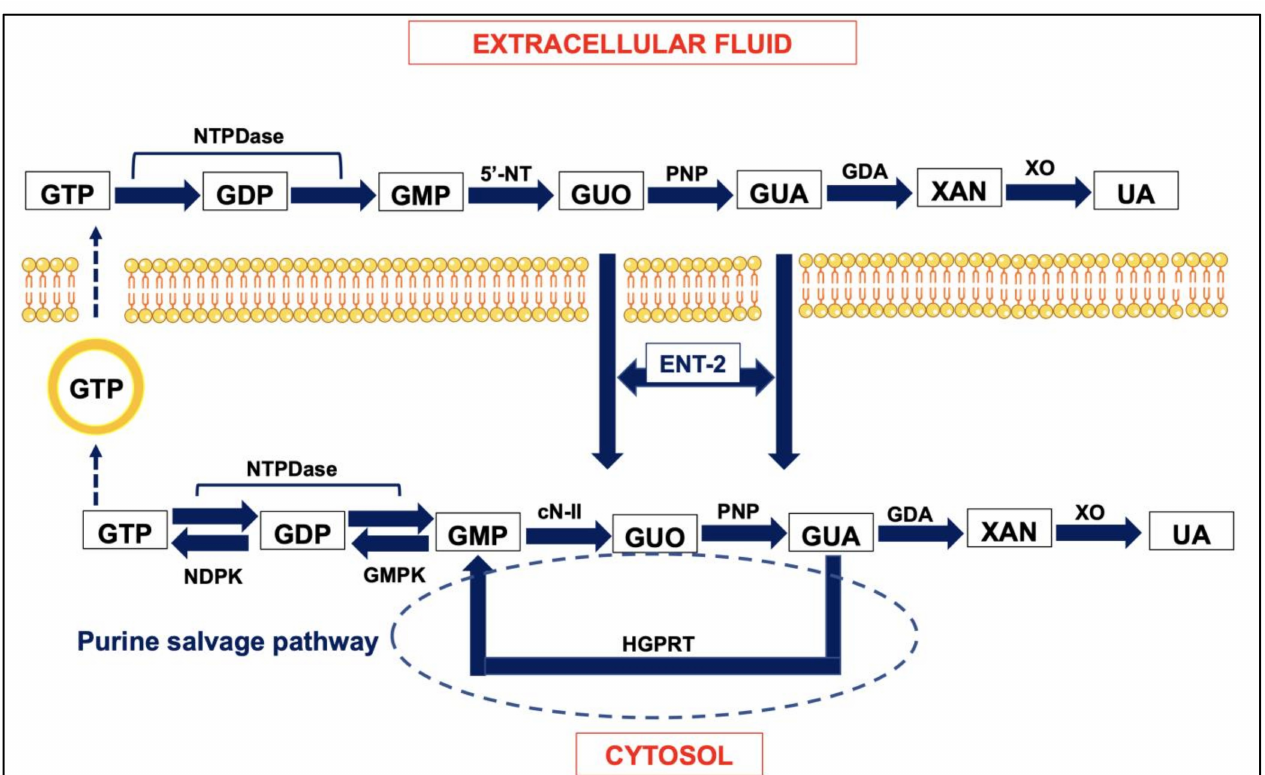
Figure 1. Intra- and extra-cellular metabolism of guanine-base purines. Guanosine (GUO) and GUA (guanine), which are formed in the extracellular fluid are mostly regained inside the cells by specific transporters (equilibrative nucleoside transporter 2, ENT-2) [38] and recycled in the purine salvage pathway to reconstitute the intracellular nucleotide pool thanks to the activity of specific kinases such as guanylate kinase (GMPK) and nucleotide diphosphokinase (NDPK) converting GMP into GDP and GDP into GTP, respectively [24,25]. GTP can be released from neurons by exocytosis [34,35] and in large amount from glial cells [36]. Other abbreviations: cN-II, cytosolic nucleotidase II; GDA, guanine deaminase; GTP, GDP, GMP, guanosine tri-, di-, monophosphate; HGPRT, hypoxanthine-guanine phosphoribosyl transferase; NTPDase, nucleotide triphosphate diphosphohydrolase; PNP,